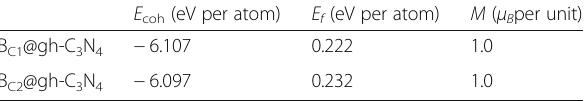
Table 1 The calculated cohesive energies, formation energies, and magnetic moments for B C1 @gh-C 3 N 4 and B C2 @gh-C 3 N